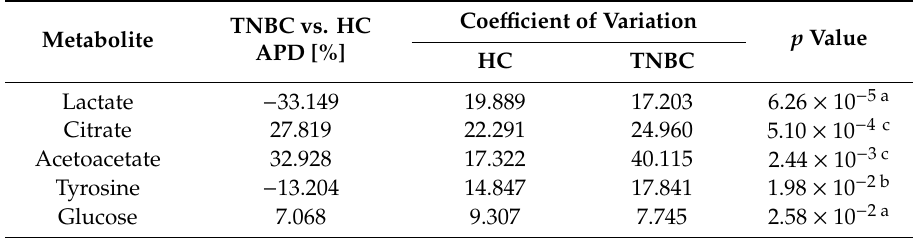
Table 2. Metabolites with significantly di ff erent profiles when comparing HC vs. TNBC, sorted by p